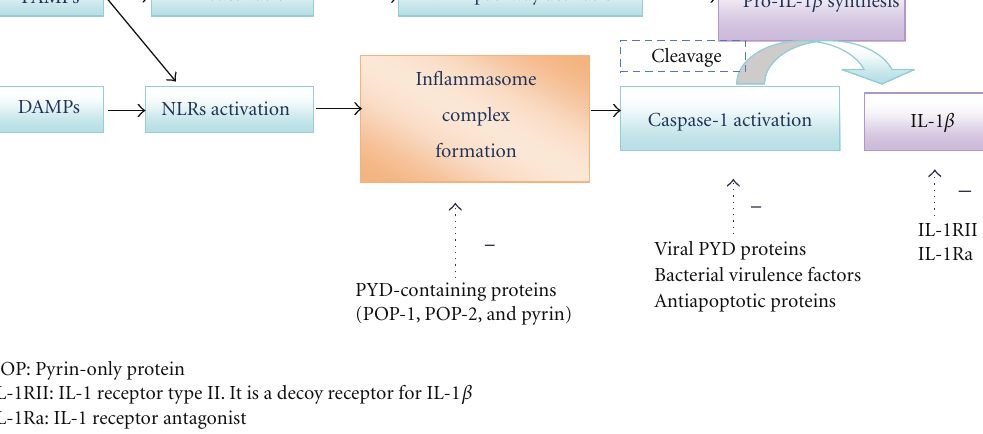
Figure 1: The inflammasome pathway of IL-1 β